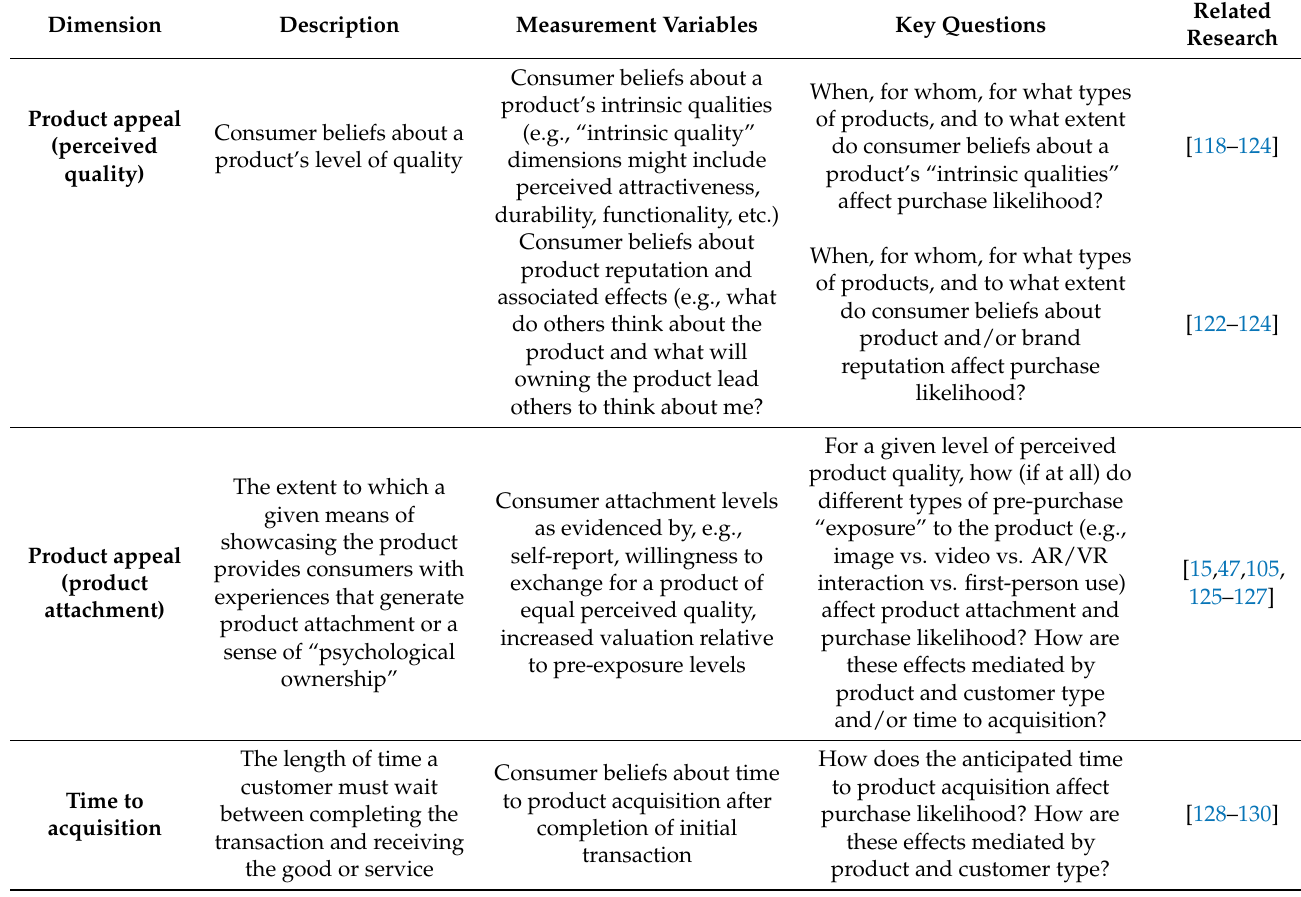
Table 2. Anticipated